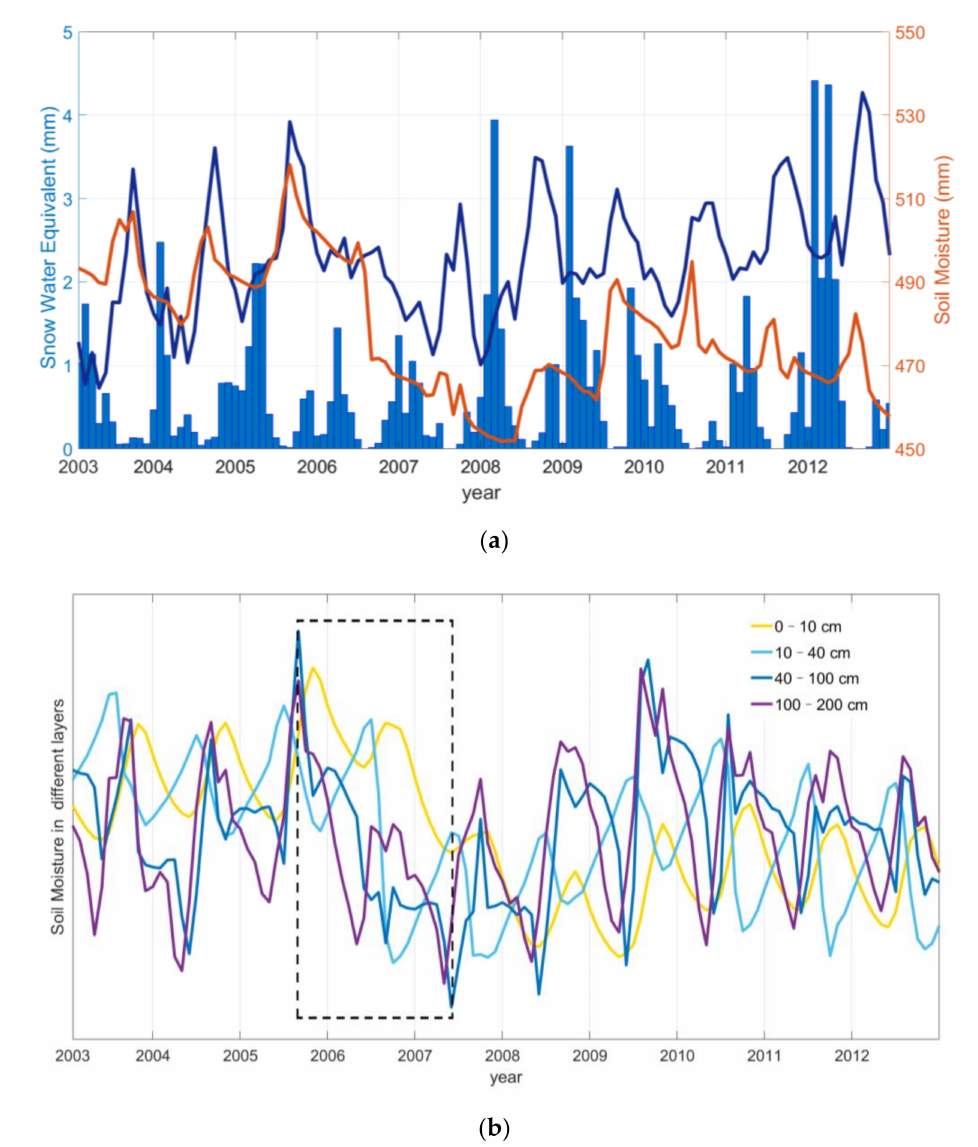
Figure 8. ( a ) Snow water equivalent (blue histogram) and soil moisture (orange line) time series in YRSR compared with TWSA (blue line); ( b ) Layered soil moisture time series derived from GLDAS-Noah